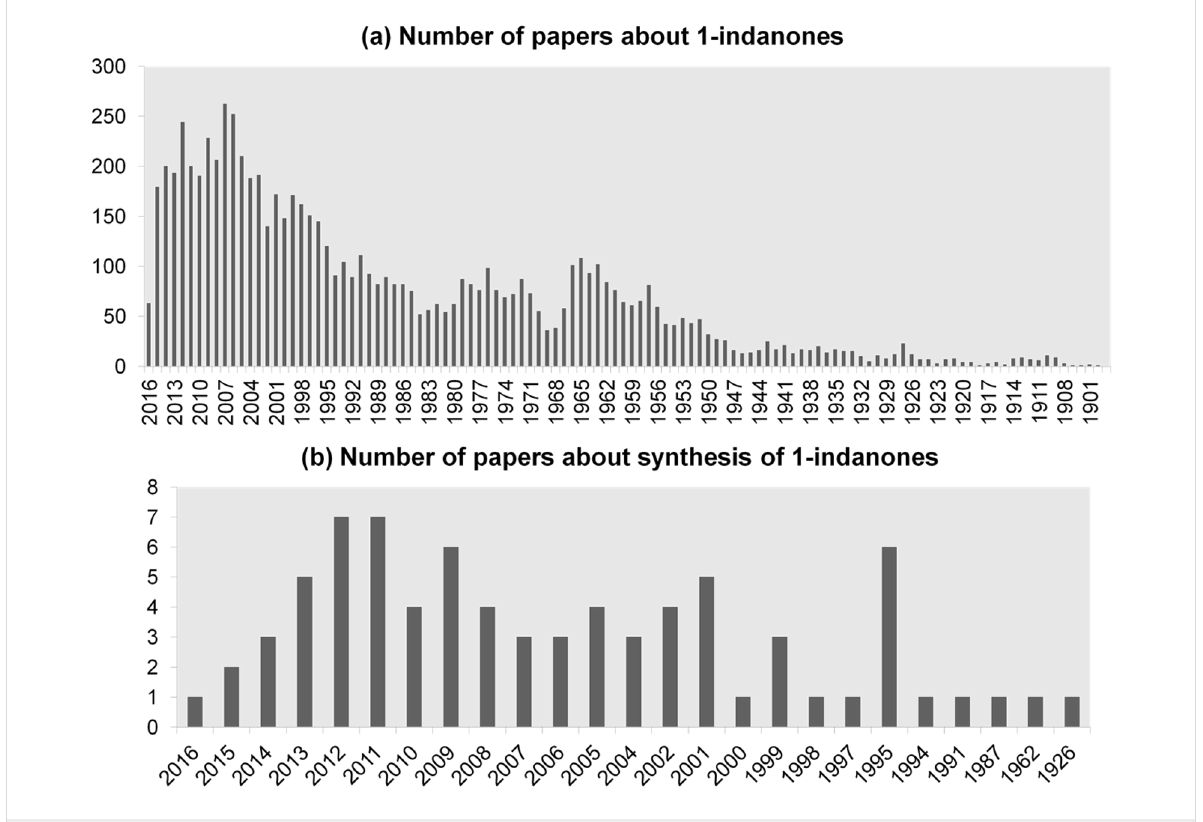
Figure 2: Number of papers about (a) 1-indanones, (b) synthesis of